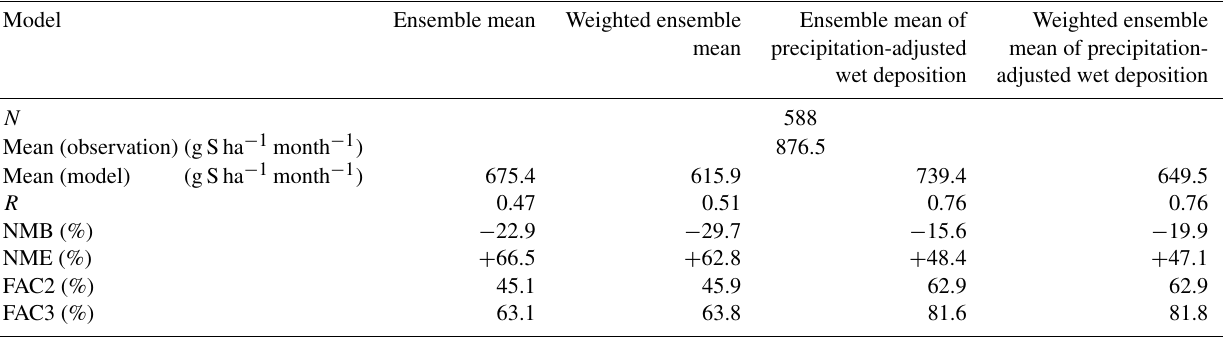
Table 6. Summary of statistical analysis of model performance by the ensemble and precipitation-adjusted approaches for the wet deposition of S.